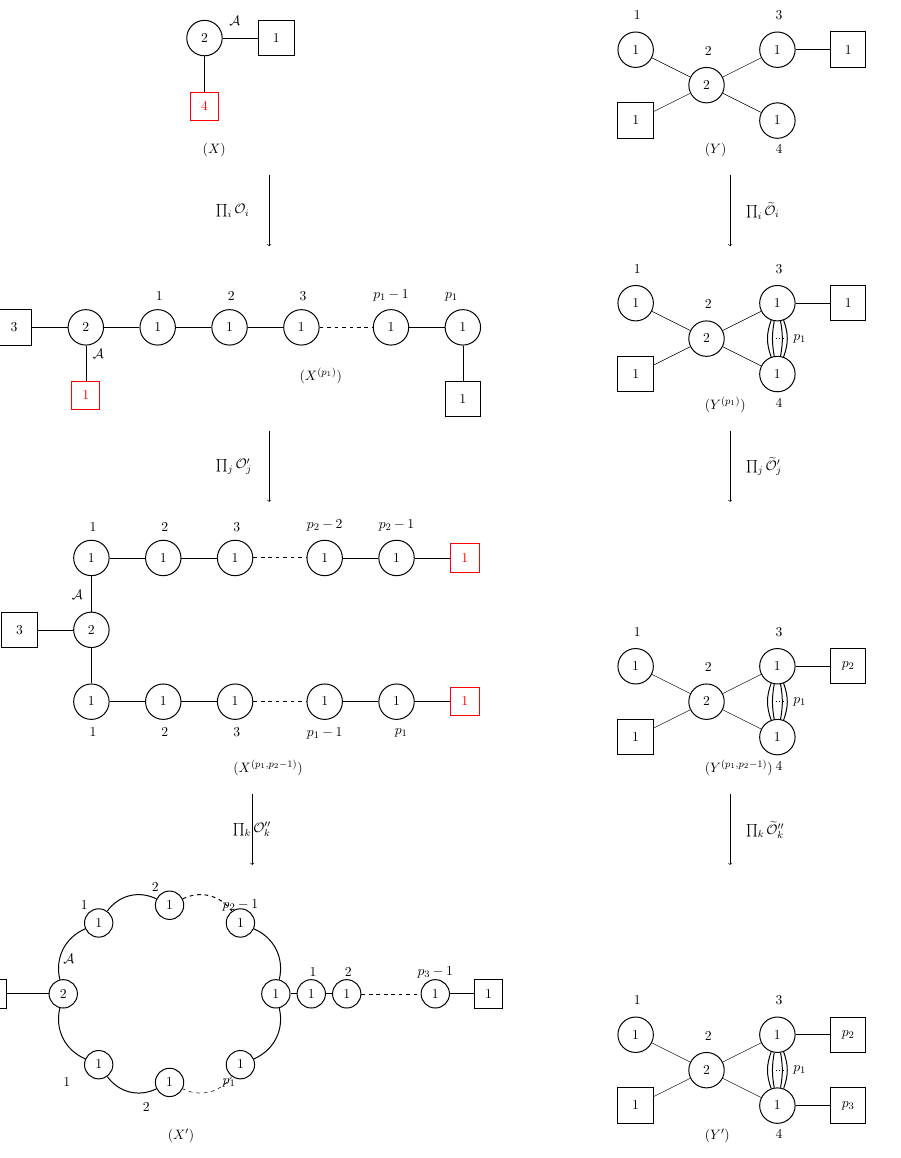
Figure 29 . The quiver ( X 0 ) and its mirror dual ( Y 0 ) in figure 26 is generated by a sequence of elementary S -type operations on different nodes. In each step, the flavor node(s) on which the S -type operation acts is shown in